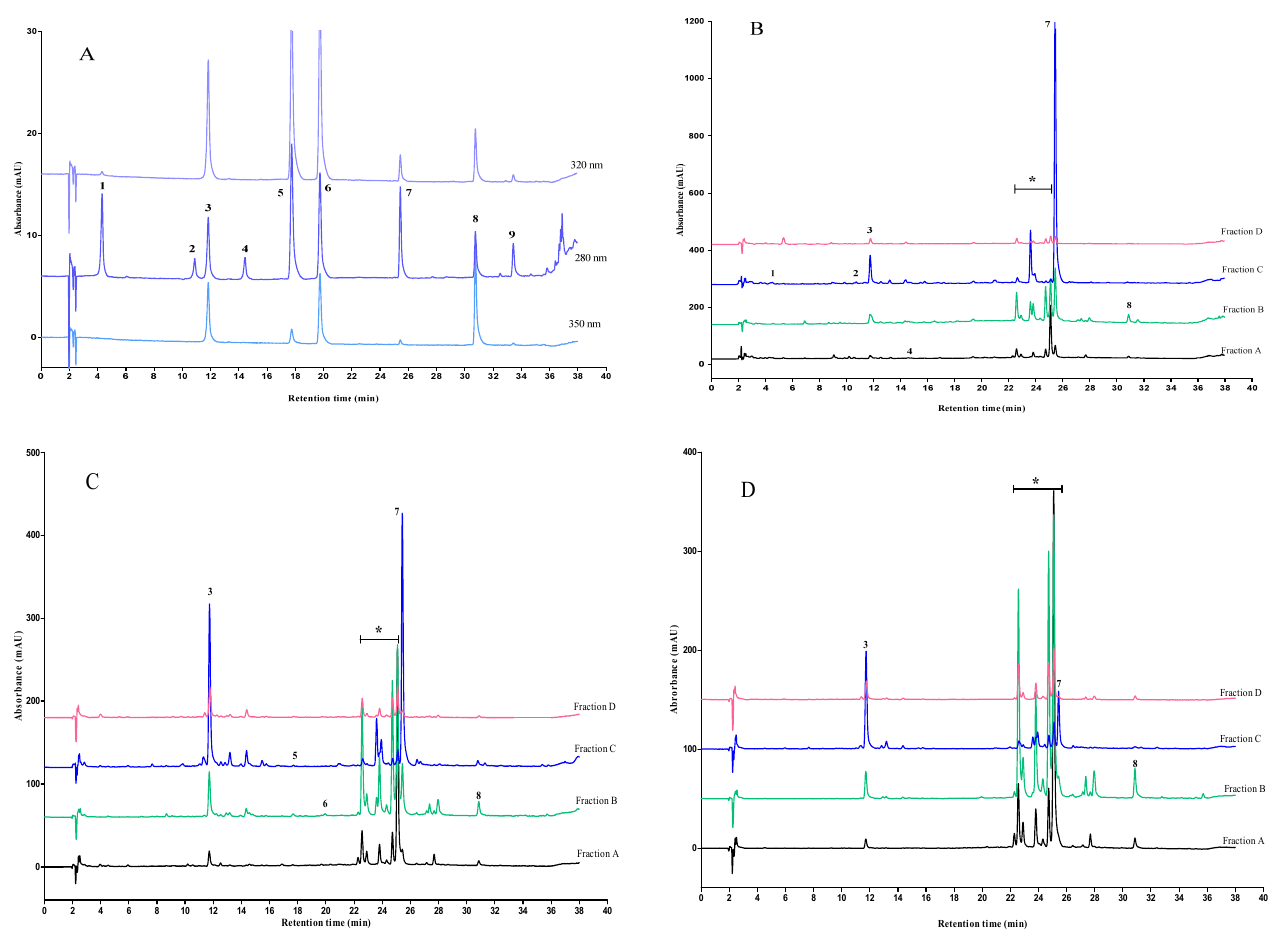
Figure 4. Chromatograms from HPLC of polyphenol standards ( A ) and ethanolic extracts of apple pomace fractions (fractions A, B, C, and D) recorded at ( B ) 𝜆 = 280 nm; ( C ) 𝜆 = 320 nm; ( D ) 𝜆 = 350 nm. Numbers identify the polyphenol peaks: 1: gallic acid; 2: (+)-catechin hydrate; 3: chlorogenic acid hydrate; 4: ( − )-epicatechin; 5: p-coumaric acid 6: Ferulic acid; 7: phloridzin hydrate; 8: quercetin; 9: phloretin; (*): unknown quercetin glycosides. The concentration of all the standards was 3.125 µg/mL. Fraction A (pulp, peel, seed, core, and stem), fraction B (peel), fraction C (seed and core), and fraction D (pulp and peel).